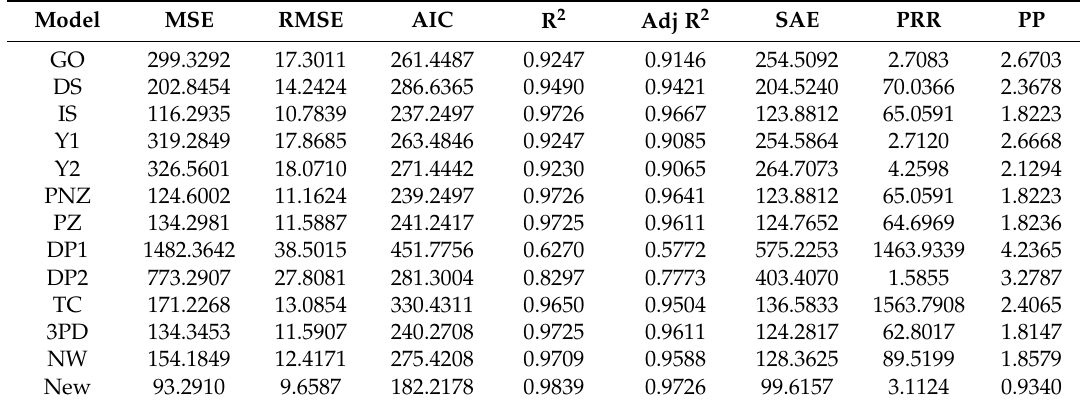
Table 6. Comparison criteria from LMRS dataset (Dataset #1).